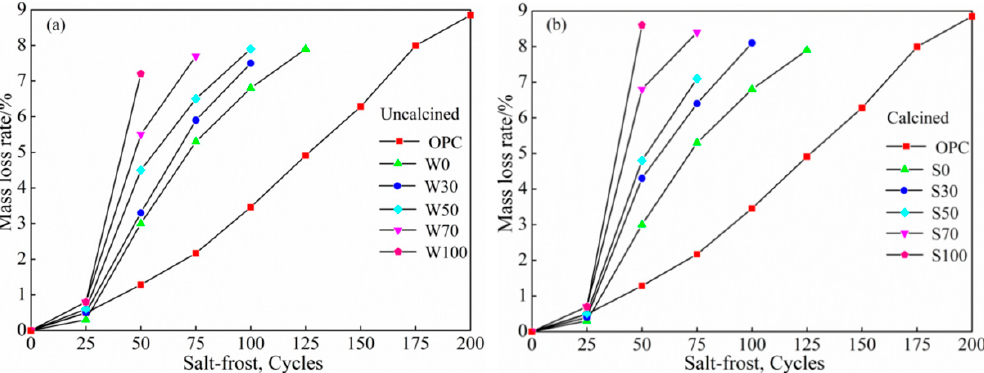
Figure 7. The relationship between cycle times of salt freeze-thaw and mass-loss rate of ( a ) uncalcined and ( b )